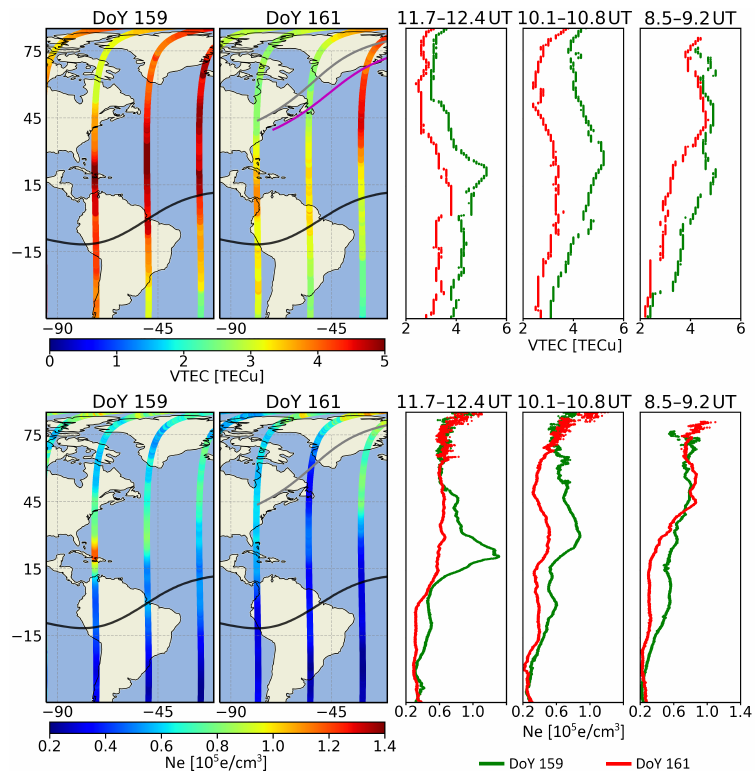
Figure 4. Ionospheric behavior using Swarm-A measurements. ( Upper panels ) present ionospheric TEC data taken by Swarm-A satellite at 850 km (at 400 km above the Swarm-A). The TEC gathered through the satellite orbit is presented over an Earth map (left panel) and as a profile with data obtained in one of the comparison days (write panel). The three satellite passes are from 45 ◦ S to ∼ 90 ◦ N, from left to right, between ∼ 11.70–12.40, ∼ 10.10–10.80, and ∼ 8.50–9.20 UT during 2 days before eclipse day (DoY 159), and eclipse day (DoY 161). The annular eclipse path at 450 km (grey line) and 850 km altitude (magenta line) are also shown on DoY 161. VTEC on DoY 161 (red dots) compared to DoY 159 (green dots) between ∼ 11.70–12.40 UT, ∼ 10.10–10.80 UT, and ∼ 8.50–9.20 UT. ( Bottom panels ) depict Swarm-A in situ electron density ( N e ) presented in the same way than the VTEC